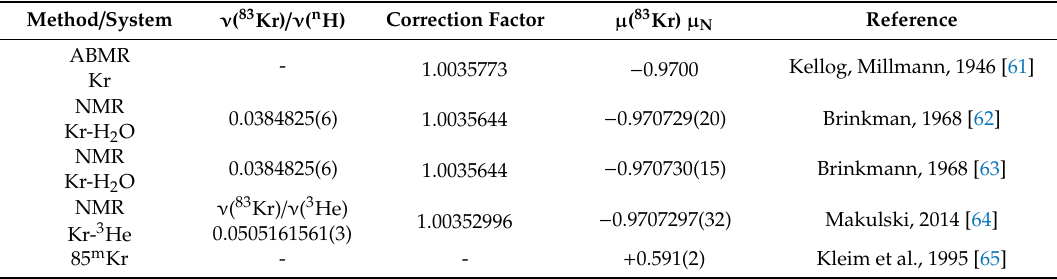
Table 5. Experimental data for evaluation of 83 Kr magnetic